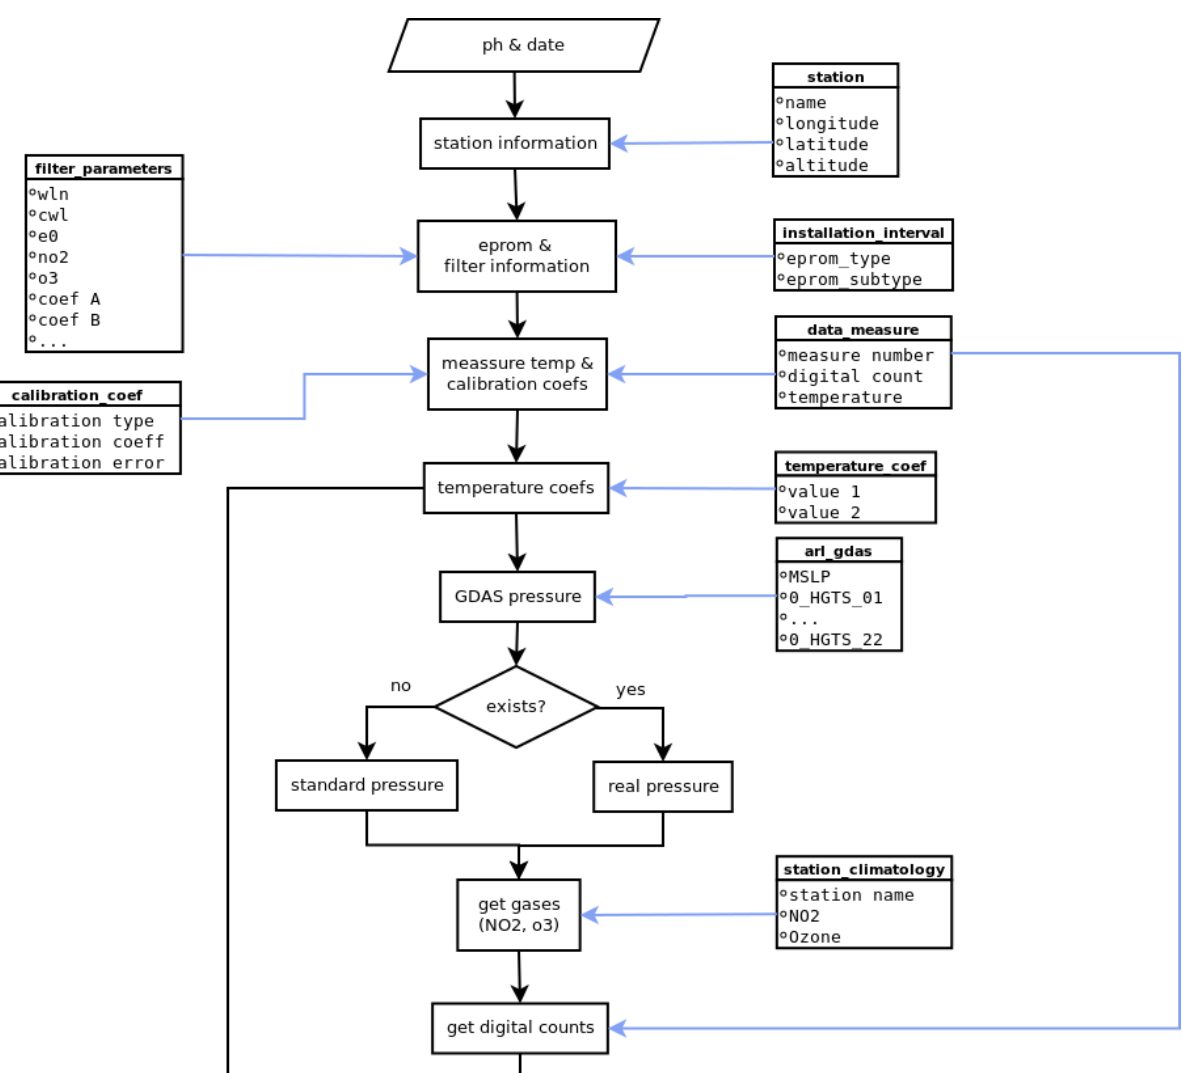
Figure 1. Flux diagram of the retrieval of necessary data to be used by the AOD